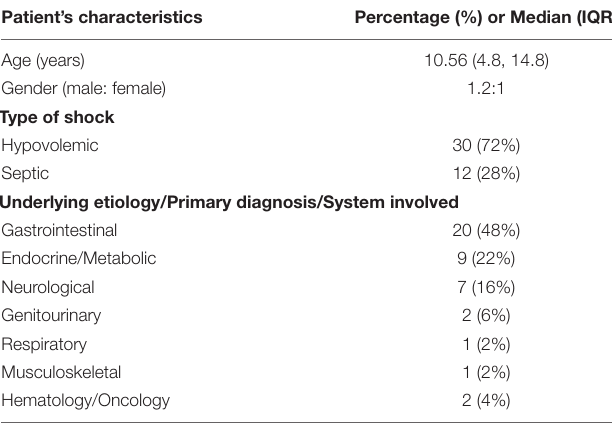
TABLE 1 | Demographic data and clinical characteristics. Patient’s characteristics